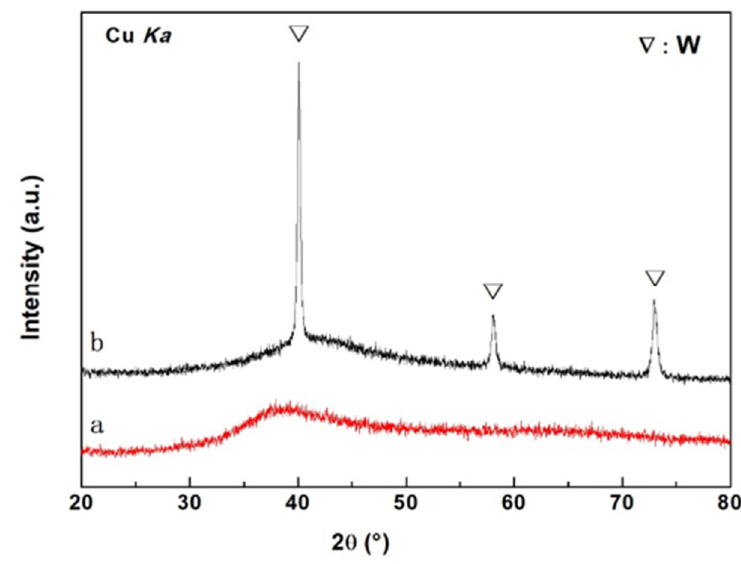
Figure 1. The X-ray diffraction patterns of two materials (curve a corresponds to the metallic glass Zr 41.2 Ti 13.8 Cu 12.5 Ni 10 Be 22.5 , curve b corresponds to the W particles/Zr 41.2 Ti 13.8 Cu 12.5 Ni 10 Be 22.5 metallic glass matrix composite).